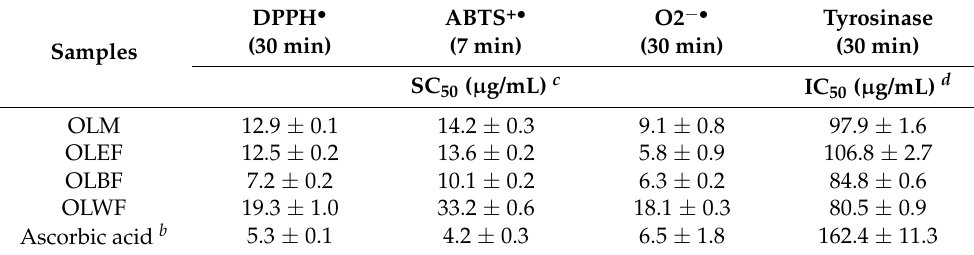
Table 1. Radical-scavenging activities and mushroom tyrosinase inhibitory activities of methanolic extract of O. laciniata (OLM) and its different soluble fractions, including ethyl acetate (OLEF), n -butanol (OLBF), and water (OLWF) fractions a